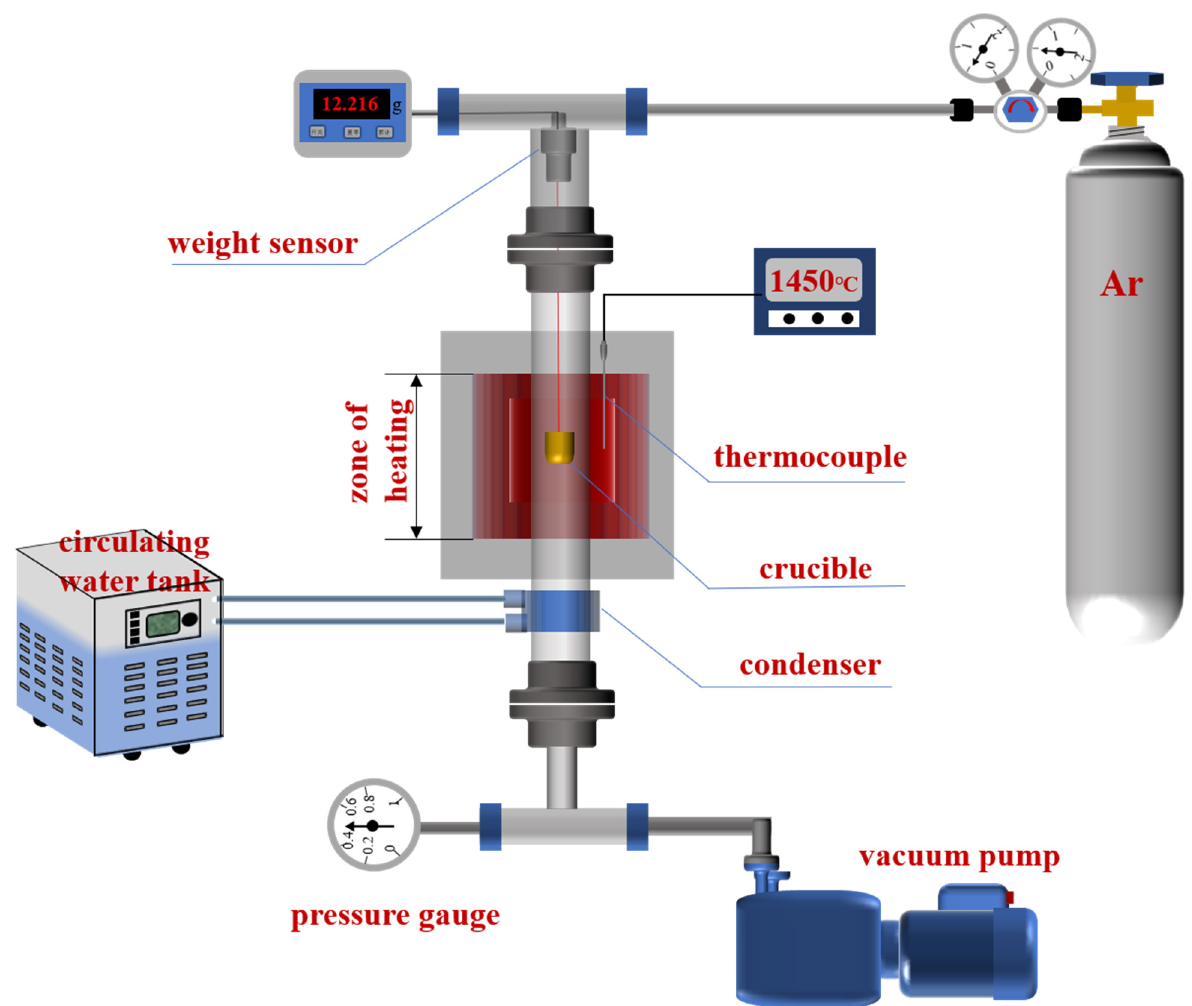
Figure 3. Working principle of the reaction device.